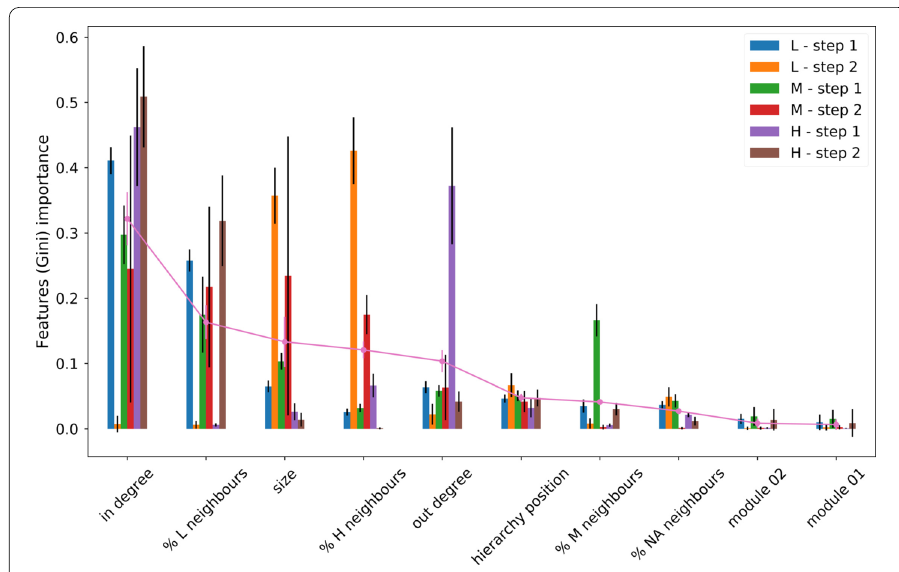
Figure 6 The ten most important features for the classification tree. Each bar represents the importance for a single classifier as detailed in Fig. 5). The pink line is the average across all classifiers. Results are averaged across months and the black bar indicate the standard deviation. The importance of a feature is computed as the (normalized) total reduction of the criterion brought by that feature (also known as the Gini